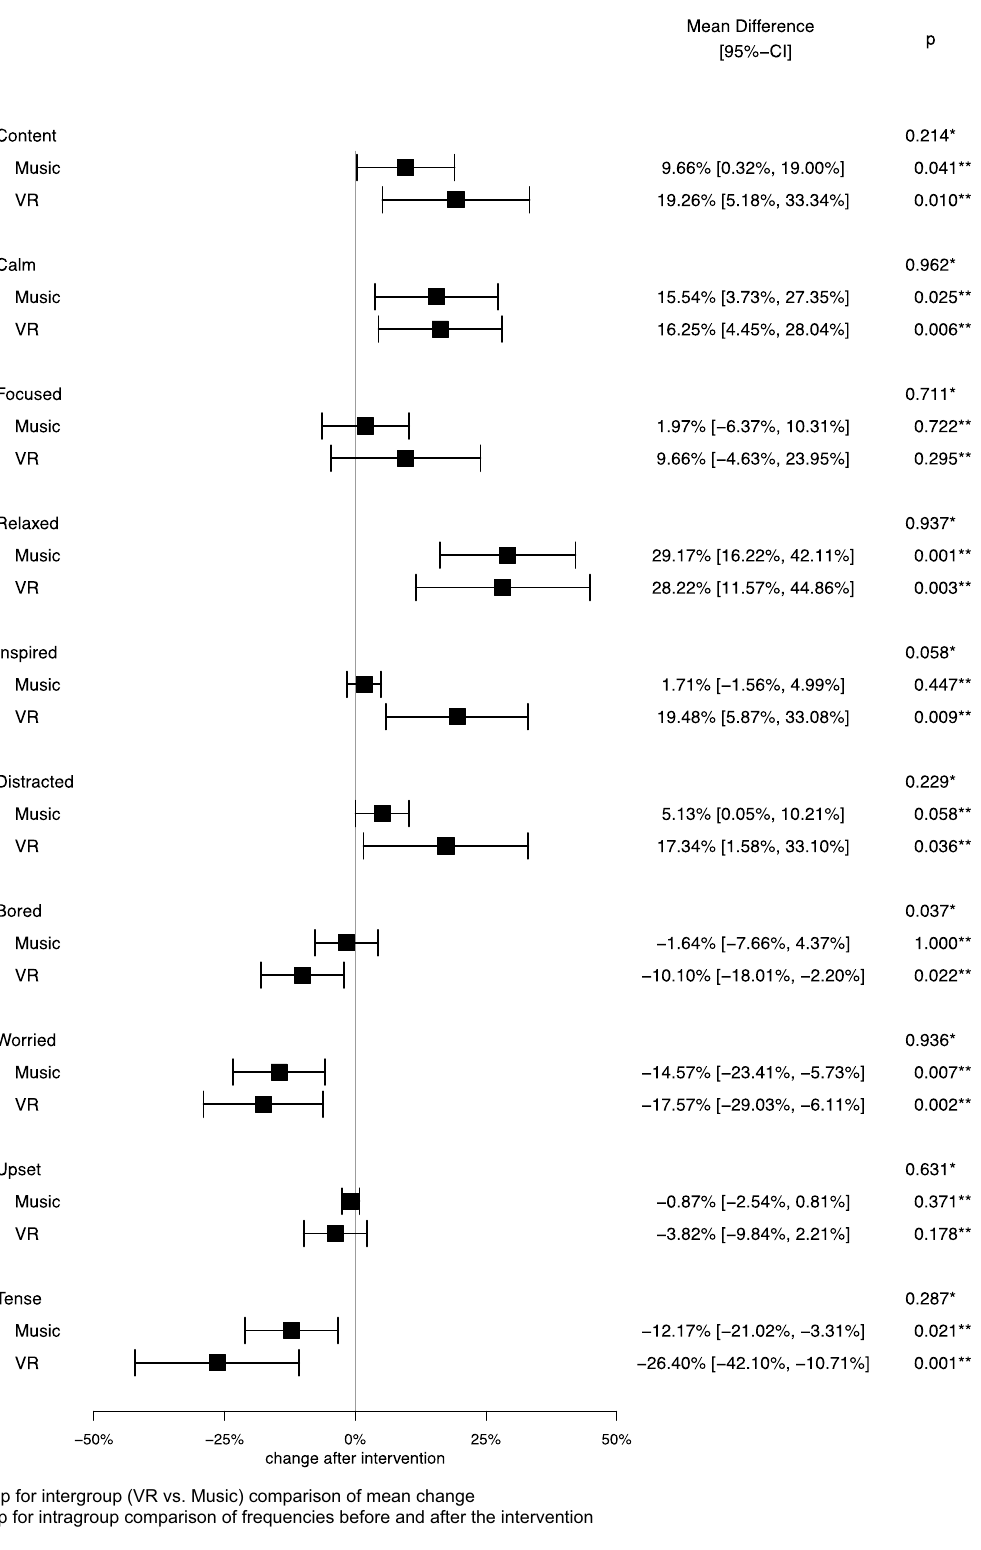
Figure 3. Averaged change in frequency of feelings after the